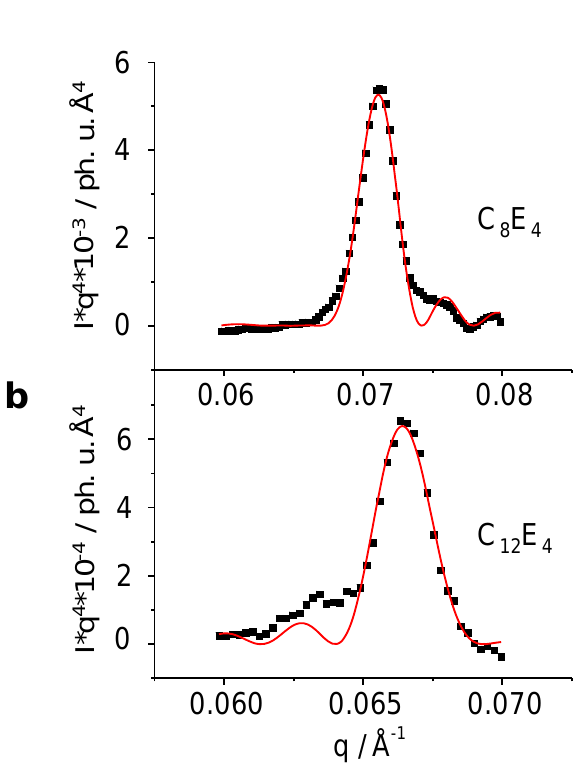
Figure 8. Porod fitting of the liquid crystal reflection allows for the determination of several experimental structural parameters as a function of time, such as the lamellar E , ( b ): C E . The intensity of the short chain length system and Figure 1). ( a ): C 8 4 12 4